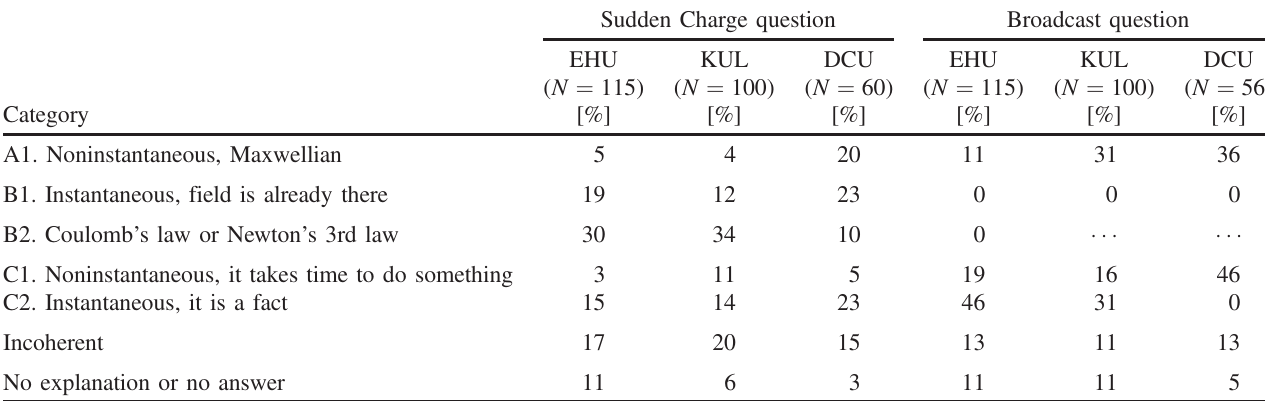
TABLE IV. Categories of answers and prevalences for the Sudden Charge and Broadcast questions. Sudden Charge